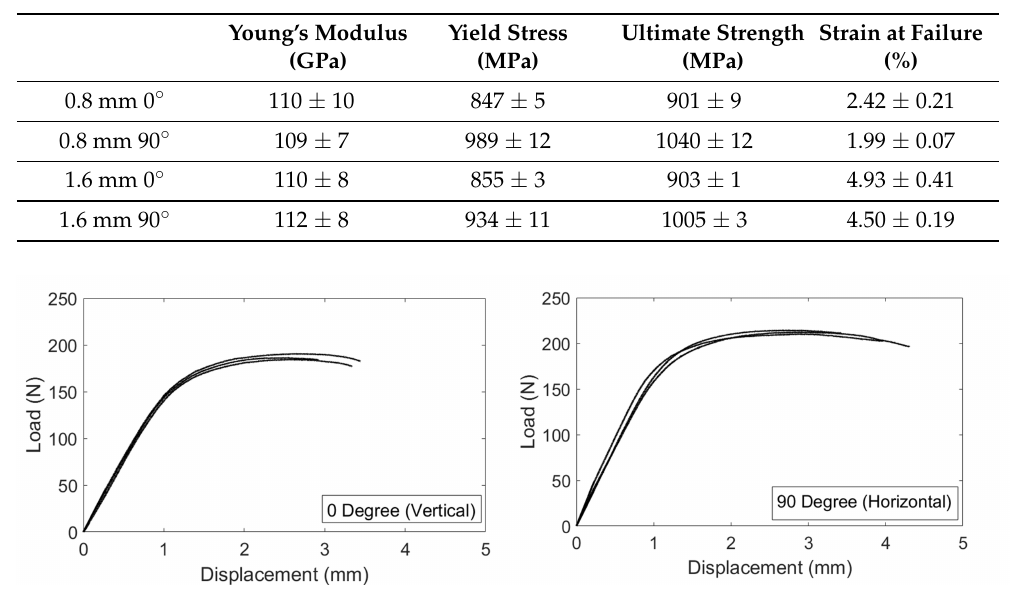
Table 3. Corrected tensile test results for 0.8 and 1.6 mm thick tensile specimens in the orientations of 0 ◦ and 90 ◦ .